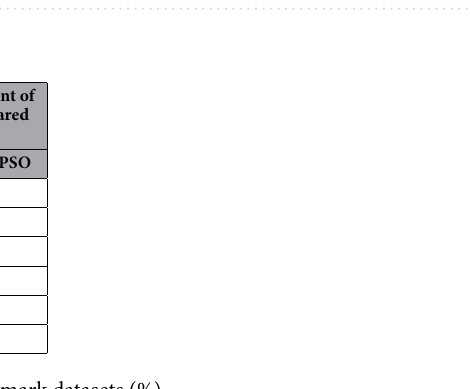
Table 8. Comparison of mean SMAPE on the 6 benchmark datasets (%).